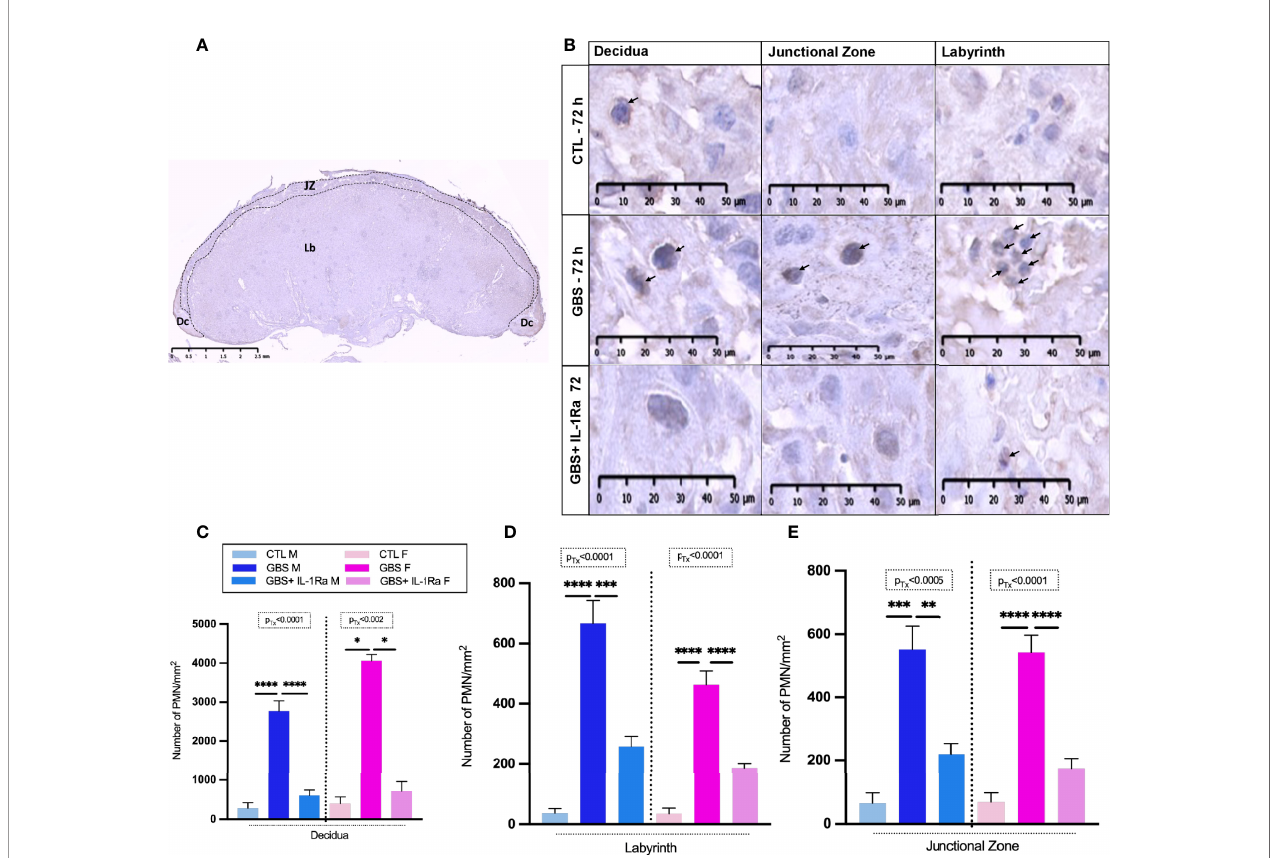
FIGURE 3 | Administration of IL-1Ra to the dam alleviated PMN in fi ltration in GBS-infected placentas. Coronal section of a rat CTL placenta stained by IHC using PMNs Ab, black dashed lines de fi ne the placental compartments [decidua (Dc), junctional zone (JZ), and labyrinth (Lb)] (A) . Representative images of PMN (arrows) in fi ltrates in the Dc, JZ, and Lb of placentas at 72 h post-GBS inoculation (B) . Mean density (n of fi eld = 3-5/compartment, fi eld unit = mm2) of PMNs identi fi ed by IHC in the Dc (C) , Lb (D) , and Jz (E) . Data were collected from four individual experiments. Statistical analyses were performed by one-way ANOVA or Kruskal-Wallis test with Dunnett ’ s or Dunn ’ s multiple comparisons multiple between the experimental groups (CTL, GBS, and GBS plus IL-1Ra); *p < 0.05, **p < 0.01, ***p ≤ 0.001, ****p ≤ 0.0001. Bars show mean ± SEM. Number (n) of male and female placentas: CTL [male (n = 3); female (n = 3)], GBS [male (n = 5); female (n = 5)] and, GBS plus IL-1Ra [male (n = 6), female (n = 6)]. Ab, antibody; Dc, decidua; F, female; GBS, group B Streptococcus; IL-1Ra, IL-1 receptor antagonist; Jz: junctional zone; Lb: labyrinth; M, male; n, number; PMN, polymorphonuclear cell; SEM, standard error of the mean Tx,